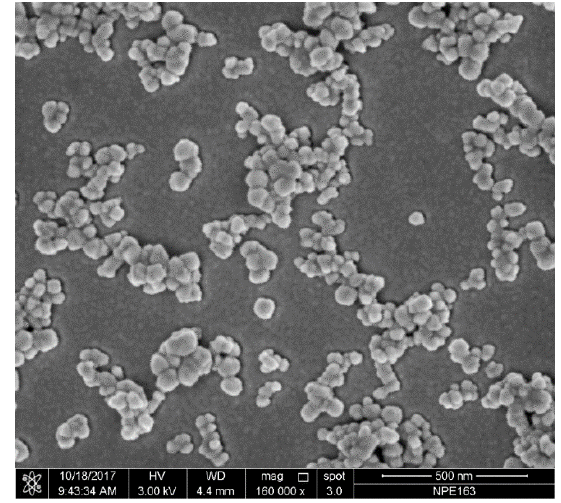
Figure 3. SEM of UiO-67-KVO(O 2 ) 2 .